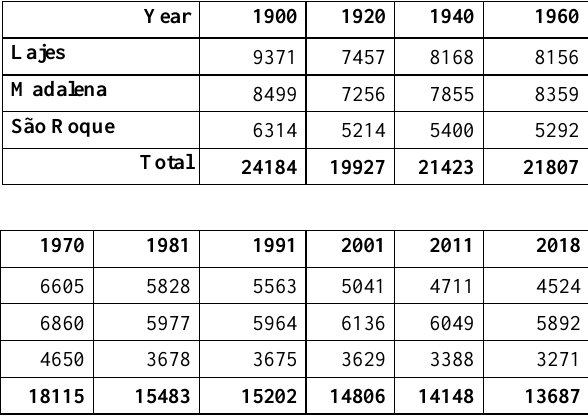
Table 1. Number of inhabitants in the municipalities since the beginning of the 20th century until 2018. Source: Serviço Regional de Estatística dos